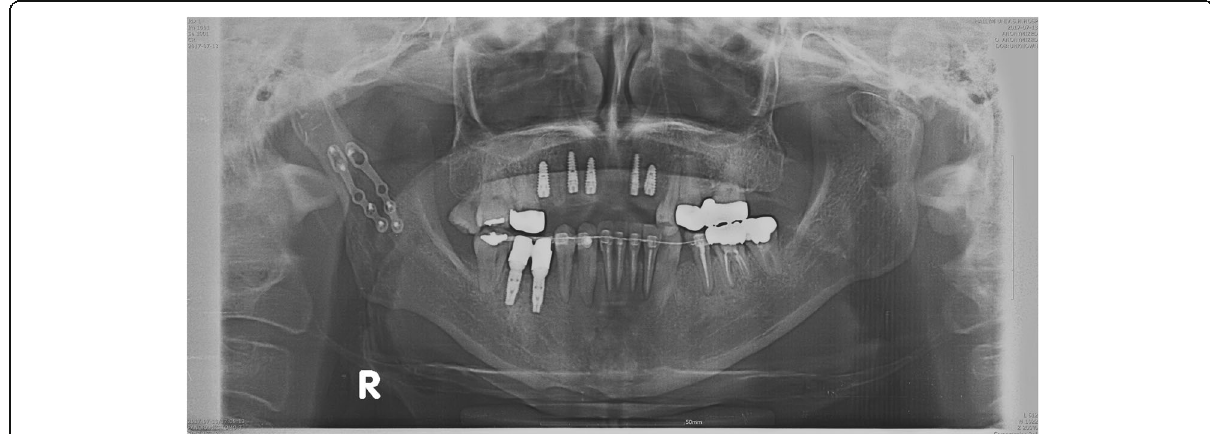
Fig. 3 Postoperative panoramic radiographs treated with YK